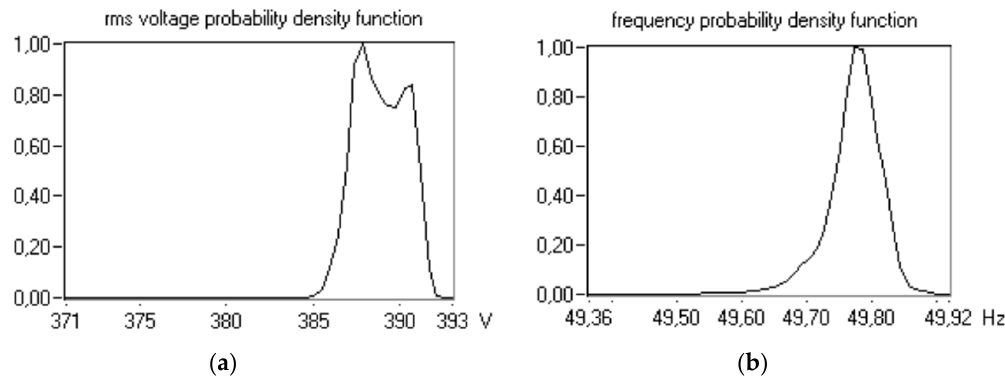
Figure 2. The probability density functions of (a) rms voltage and (b) frequency in a ferry’s 380 V network during maneuvering [4].